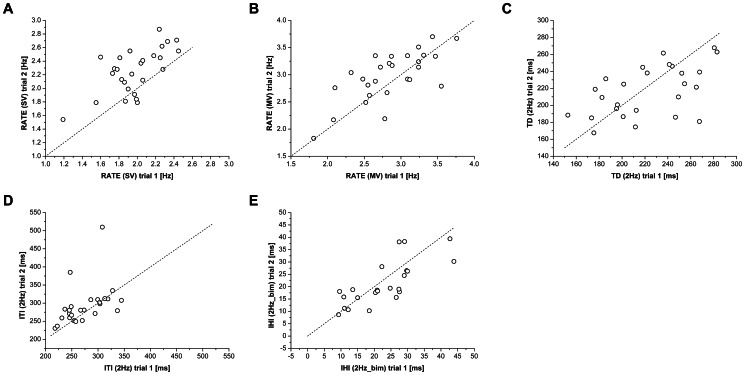
Test-retest reliability of the motor performance parameters.
(A-E) Motor performance parameters in the two sessions performed one-month apart in a group of healthy controls (trial 2 vs. trial 1), with respect to the identity (i.e., the dashed line represents the bisector).